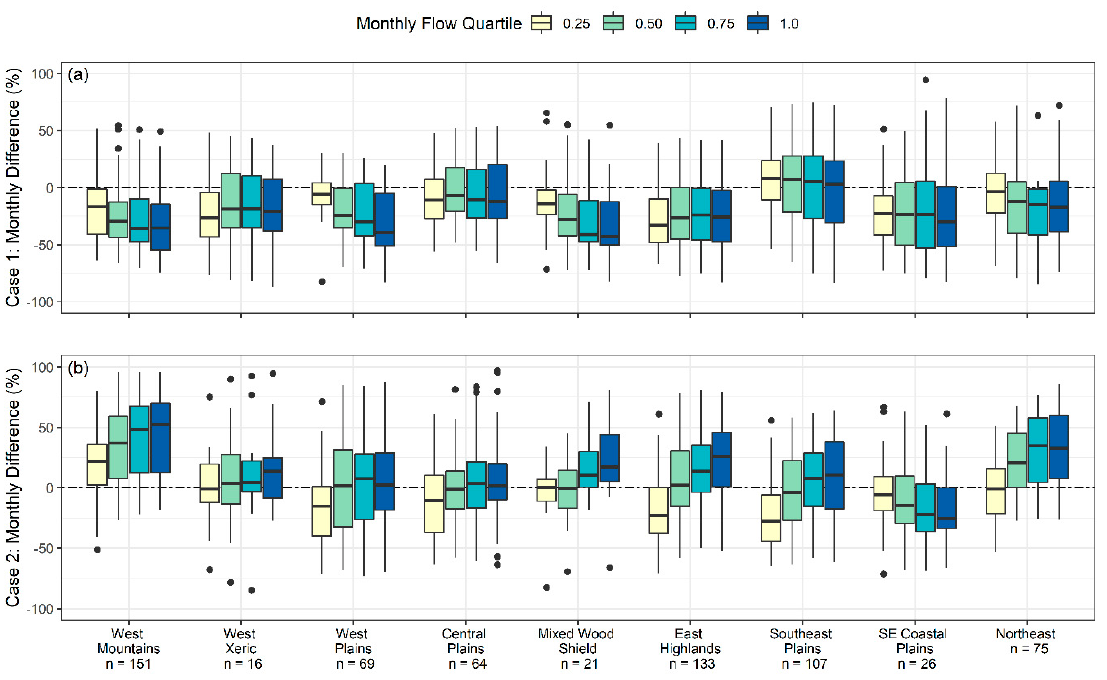
Figure 11. ( a ) the difference in average monthly percent contributions to total flow of GWF and OHS base flow (case 1), and ( b ) GWFSF and OHS base flow (case 2) over normalized monthly flow quartiles (0.25, 0.5, 0.75, 1) and aggregated ecoregions [34]. Values greater than 100 percent are due to the comparison of HRU-based volumes with routed-based stream segment volumes. The dotted line emphasizes a zero difference.